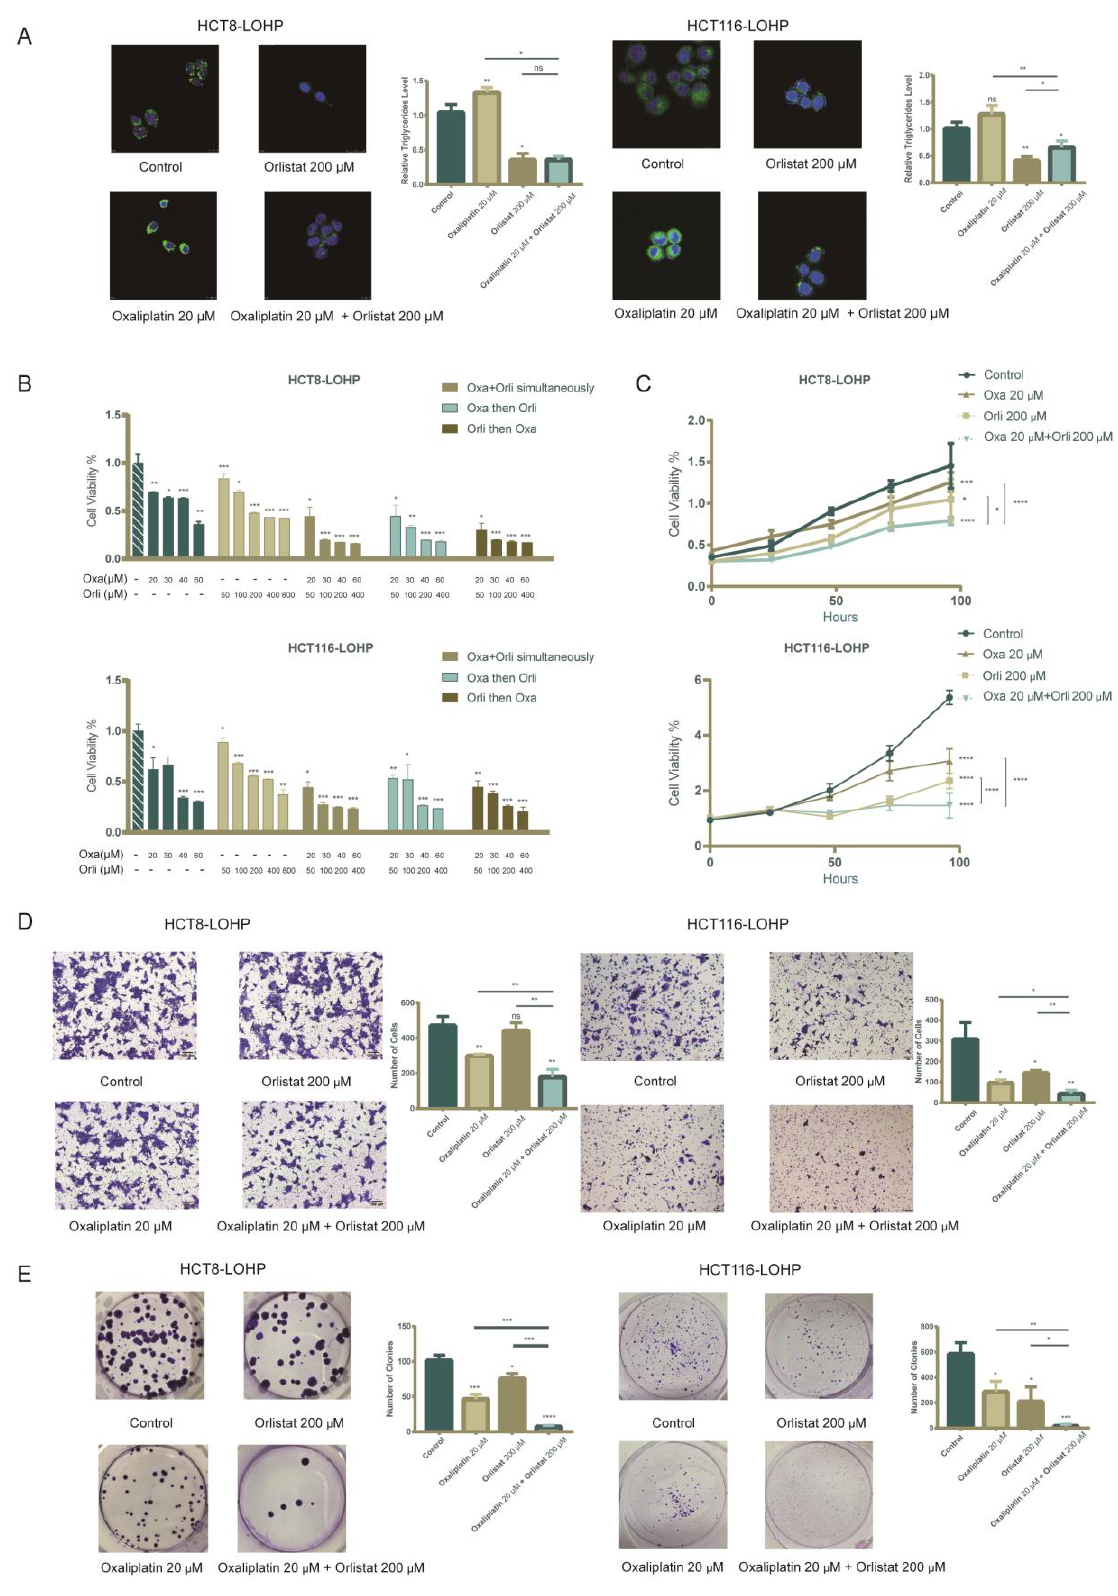
Figure 3. Synergistic inhibition fatty acid biosynthesis combined with oxaliplatin diminished cell viability, clonogenicity, and migration. ( A ) There was a significant decrease in intracellular neutral lipid droplets and triglycerides after treatment with Orlistat for 72 h. ( B ) Cell viability in HCT116- LOHP and HCT8-LOHP cells upon different treatment schemes: oxaliplatin, Orlistat, combination simultaneously, sequentially, and reverse-sequentially for 72 h. MTT assay was performed to assess